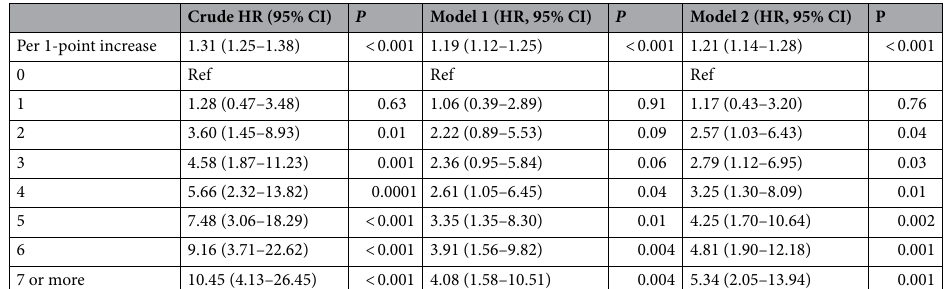
Table 3. Association of CHA2DS2-VASc scores with primary outcomes in the OAC treatment group (n = 5500). Model 1: age, initial NIHSS, prior anticoagulation. Mode 2: age, initial NIHSS, BMI, arrival time, dyslipidemia, smoking, prior anticoagulation, prior statin, antihypertensive treatment, antidiabetic treatment, statin treatment, reperfusion therapy, creatinine, glucose, SBP, large artery diseases, multiple lesions, stroke mechanism